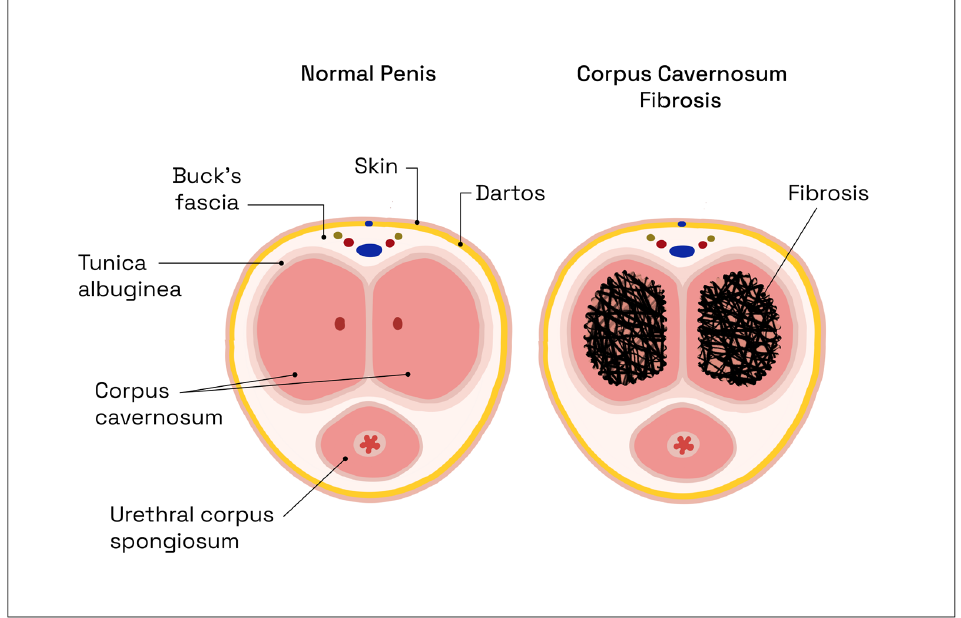
Figure 3. Comparative axial anatomic sections of the penis, illustrating the progressive process of fibrotic connective tissue buildup within the corpus cavernosum. Illustrations adapted from Milenkovic et al. [38].